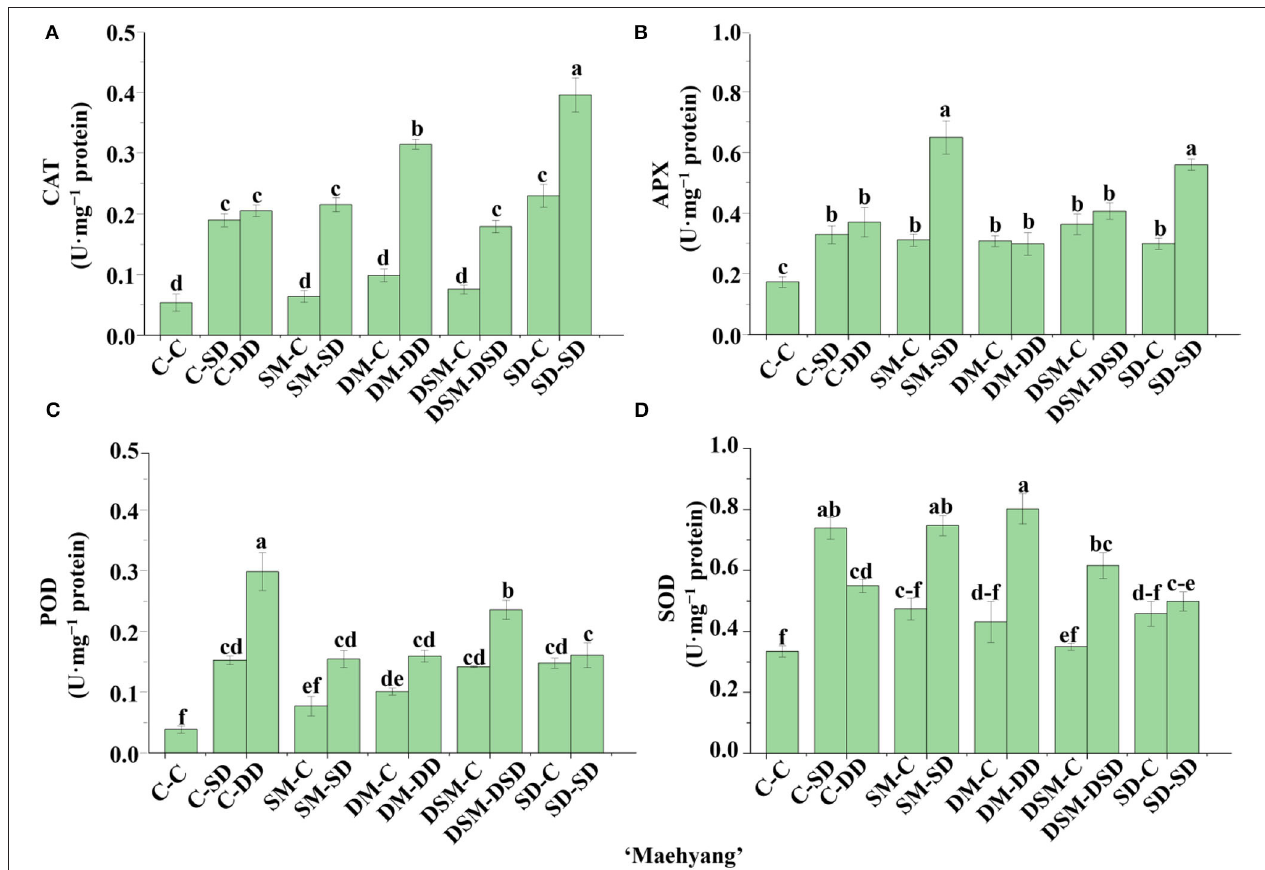
FIGURE 12 | Activities of CAT (A) , APX (B) , POD (C) , and SOD (D) in leaves of “Maehyang” as affected by the Si treatment after subjection to 43 ◦ C for 7 days. Lowercase letters indicate significant differences calculated by the Duncan’s multiple range test at p ≤ 0.05. See Figure 1 for descriptions of treatment